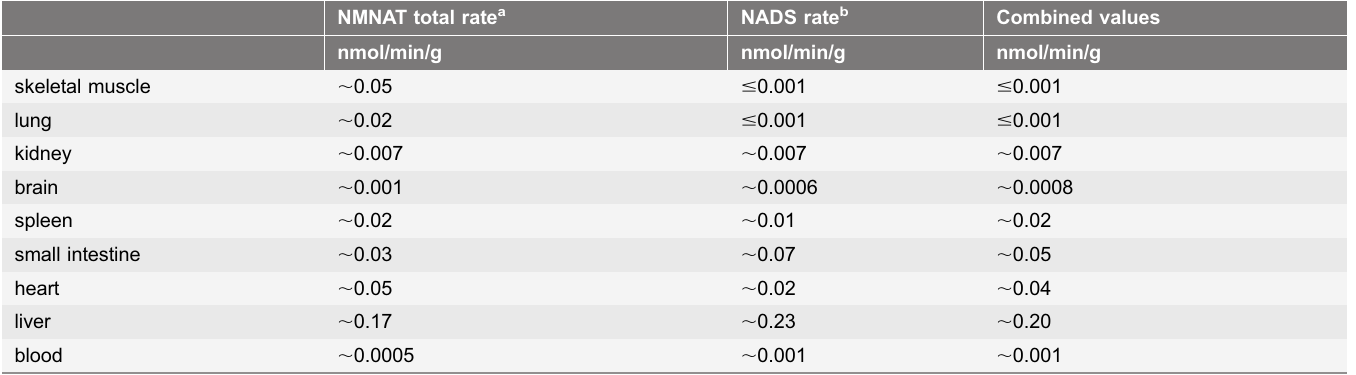
a Sum of the three NMNAT isozyme activities individually calculated as in Table 2 but versus the NaMN substrate ( K b Values are calculated from the steady-state kinetic equation (3) shown in Methods, using the NADS activities measured at saturating substrates (Figure 3A) as V max values, the NaAD, ATP, and glutamine levels (nmol/g, Figure 4) as micromolar concentrations, and the K m values from [43].